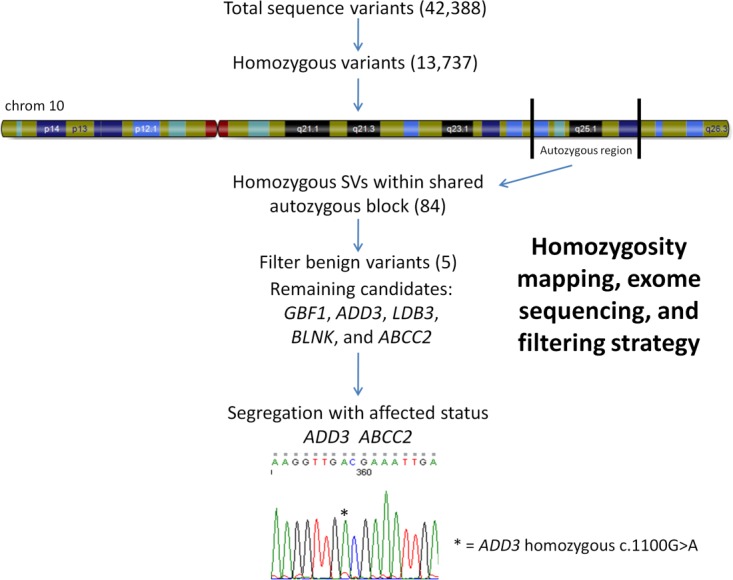
Homozygosity mapping, exome and Sanger sequencing, and filtering algorithm. Homozygous region on chromosome 10 shared by affected family members and filtering strategy applied to interrogate sequence variants (SVs) generated by exome sequencing. A homozygous c.1100G>A mutation was found in all affected individuals, whereas unaffected individuals were heterozygous for this mutation. [Color figure can be viewed in the online issue, which is available at http://www.annalsofneurology.org.]